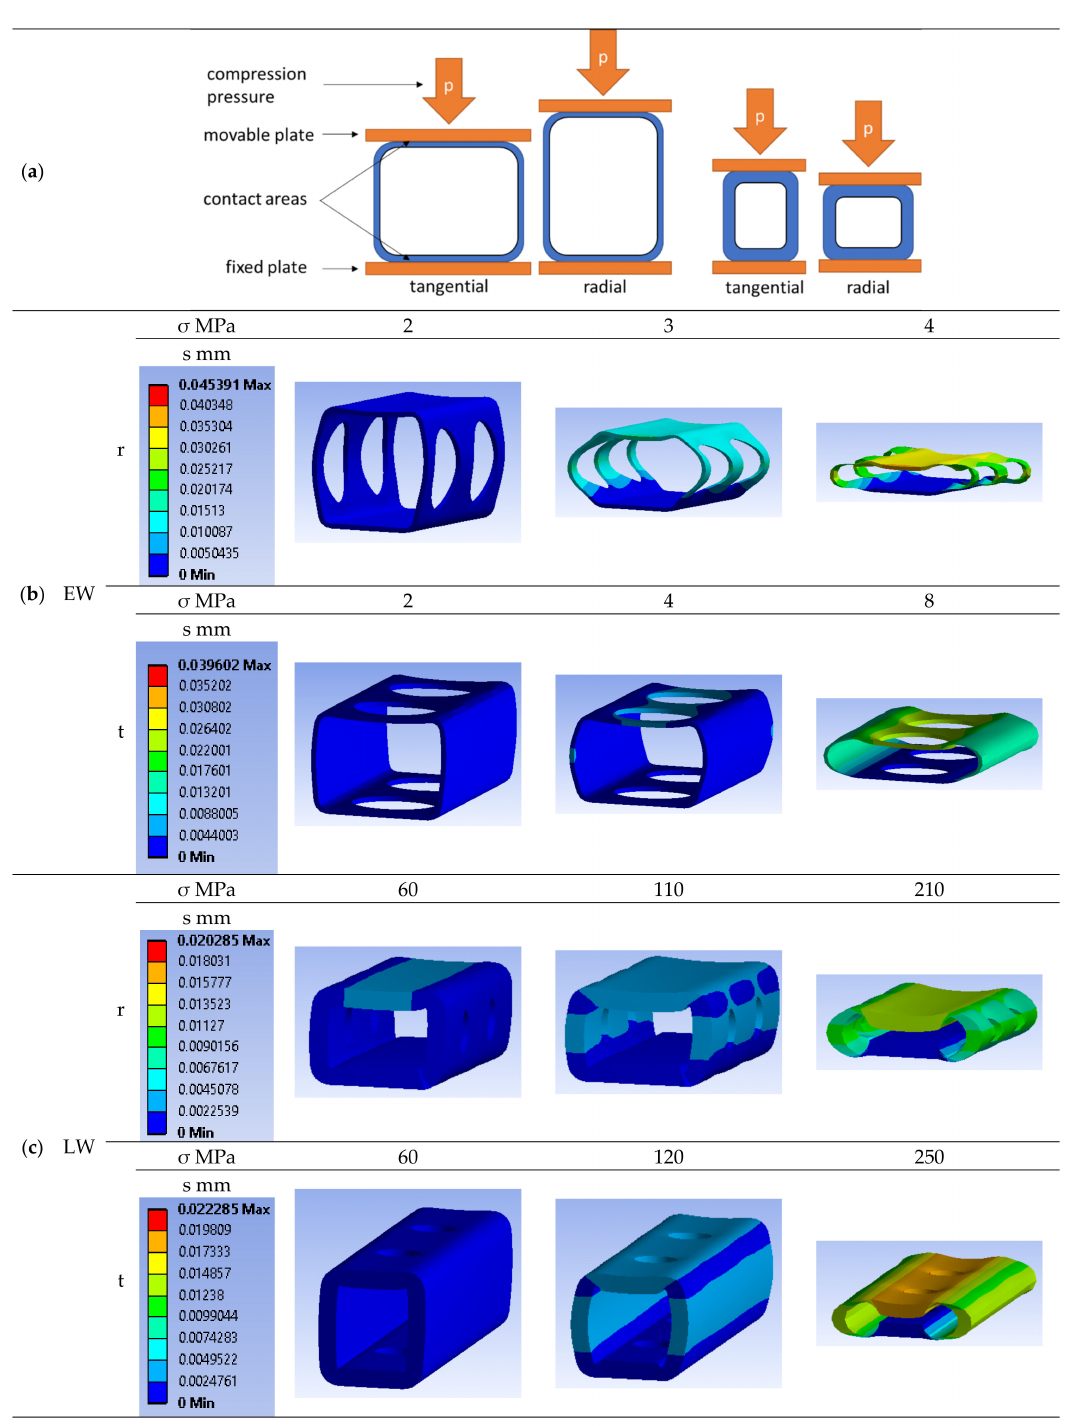
Figure 8. Selected boundary conditions ( a ) and simulation results of radial (r) and tangential (t) compression of EW ( b ) and LW ( c ) tracheids at 23 ◦ C and 12% moisture